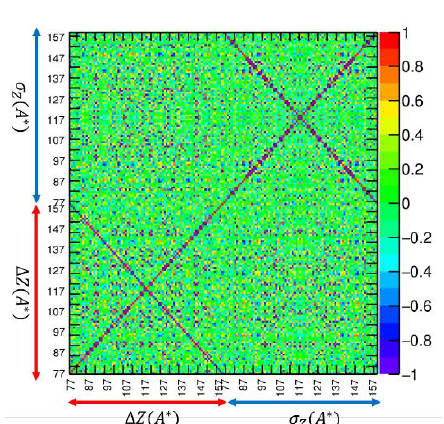
Fig. 9. The correlation matrix of direct-Zp parameters as a function of masses.